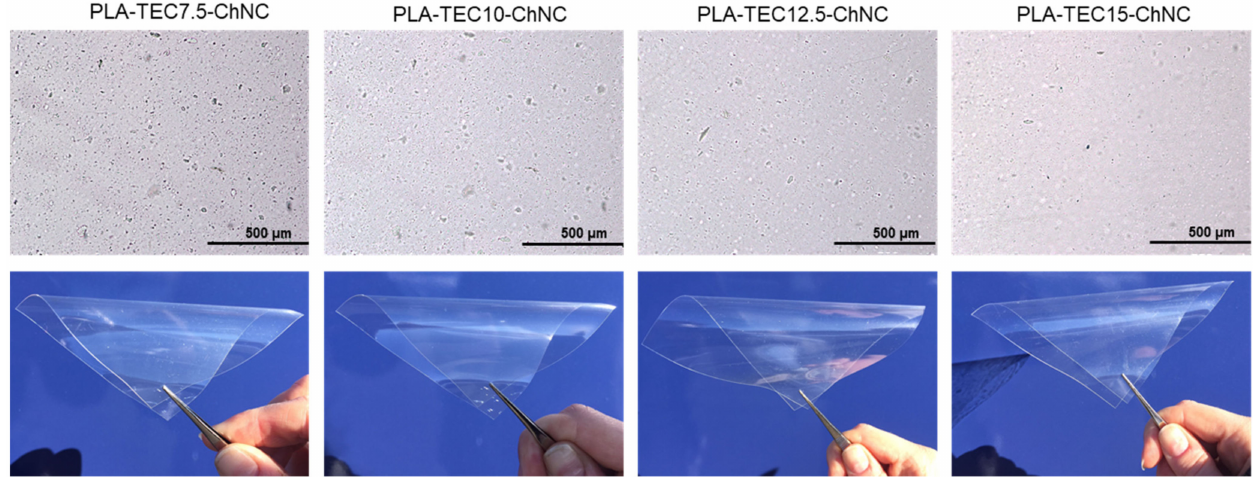
Figure 3. Optical microscopy images showing the dispersion of the ChNCs in nanocomposite films (on the top ) and their corresponding photographs showing their visual appearance (on the bottom